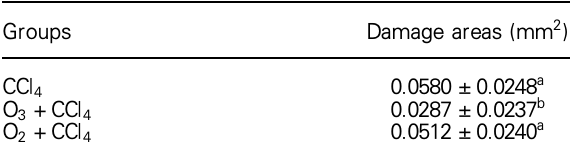
Table 2. Morphometric evaluation of the hepatic damage by lipidosis